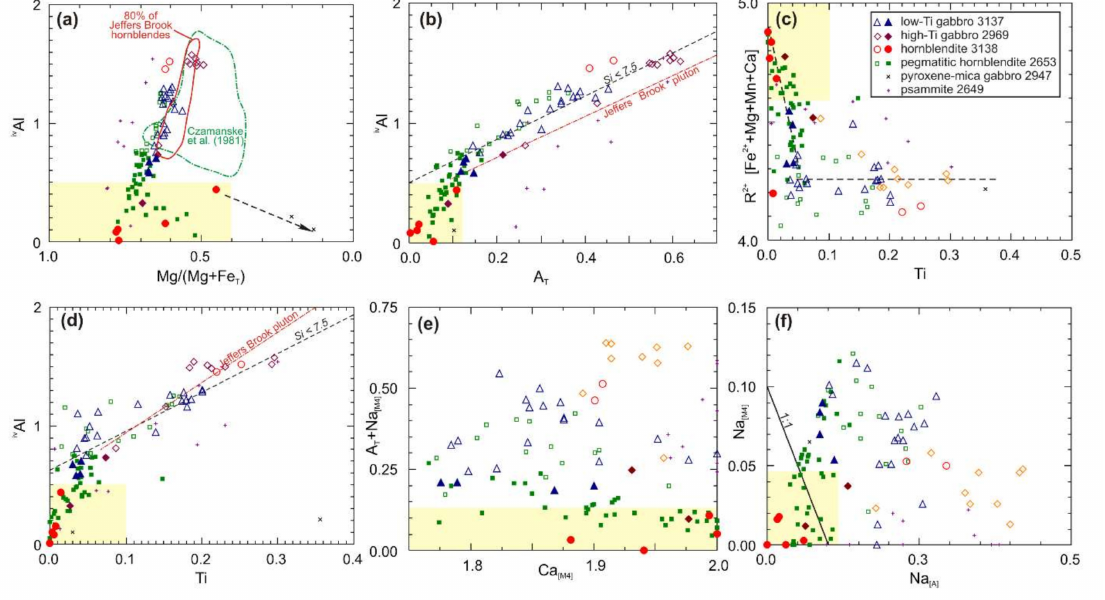
Figure 7. Plots showing the various element substitutions of the studied amphiboles. The field for the actinolite is shown in yellow. The atomic formulae were calculated on the basis of the mean of 13 and 15 cations in order to facilitate comparison with older data. ( a ) Plot of iv Al against Mg / (Fe T + Mg) showing the systematic change in Mg content from pargasite to actinolite. Note the increasing Fe in some actinolites. The Je ff ers Brook pluton and Japanese plutons of Czamanske et al. [16] have lower Mg / (Fe T + Mg). ( b ) Plot of tetrahedral iv Al versus A site occupancy, to illustrate the edenite substitution. ( c ) Plot of R 2 + against Ti, to illustrate the substitution Ti R 2 + = 2 vi Al. ( d ) Plot of iv Al against Ti, to illustrate the substitution Ti + iv Al = vi Al + Si. ( e ) Plot of Na [M4] + (Na + K) [A] vs. Ca [M4] to illustrate the possible richterite substitution. Note the weak systematic trends for the di ff erent samples. ( f ) Plot of Na [M4] vs. Na [A] , to illustrate the possible richterite